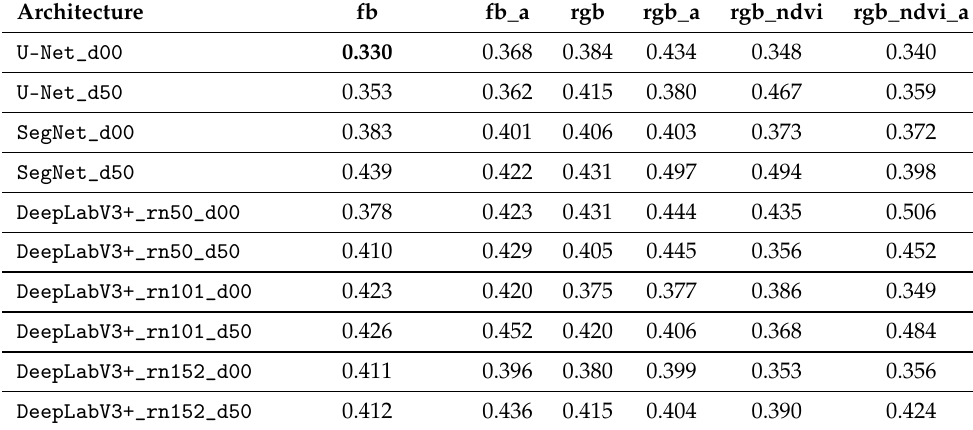
Table 2. Dice loss values over the validation dataset for different architectures and settings on the multi-class dataset. For rows: dN% stands for dropout, N specifies the dropout ratio, and rnN specifies the ResNet version used as a backbone model for DeepLabV3+. For columns: fb stands for the dataset utilizing the full-band images, rgb stands for the dataset utilizing only the red, green, and blue bands, rgb_ndvi represents rgb enhanced by the NDVI, and _a represents the augmented version of the dataset.